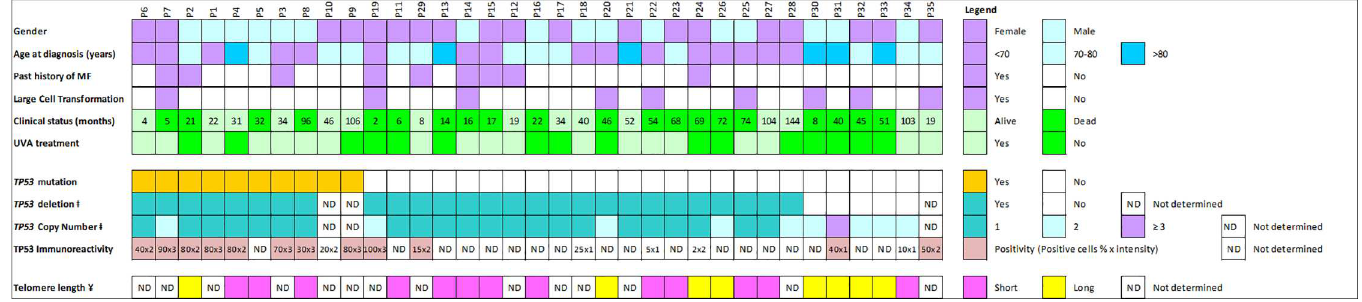
Fig 2. Clinical data and somatic alterations of TP53 gene in Se´zary syndrome. Age at diagnosis (years), Clinicalstatus means survival time in months after diagnosisof Se´zary syndromeuntil the death or last clinicalstatus, ⱡ data determined by fluorescence in situ hybridization, ¥ data determined by quantitativefluorescence in situ